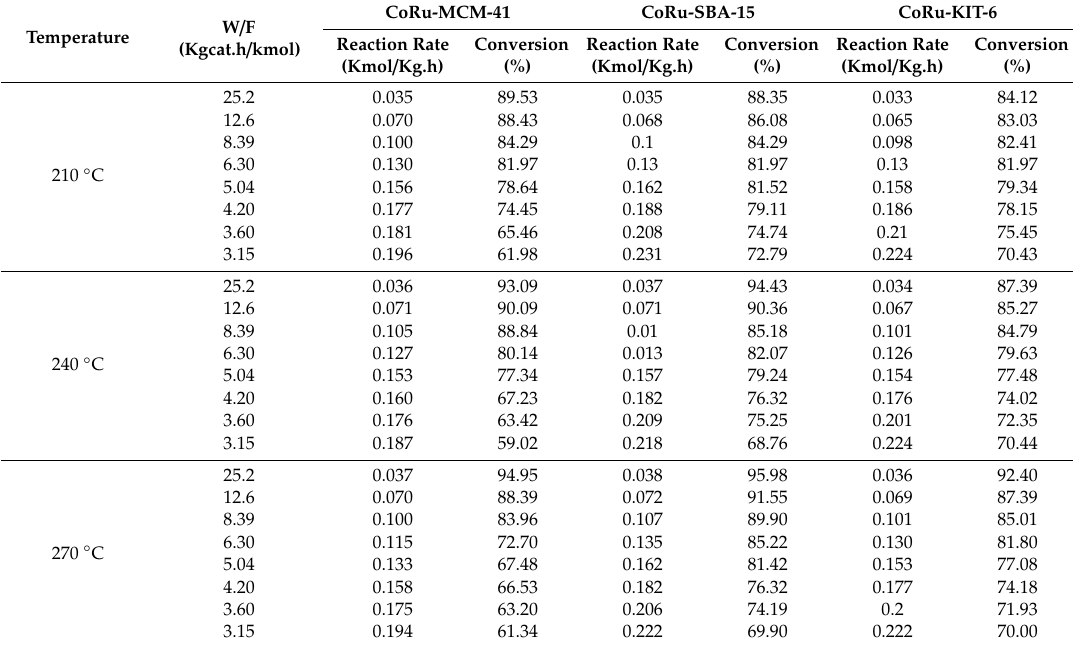
Table 4. Kinetic experimental data for all the catalysts.